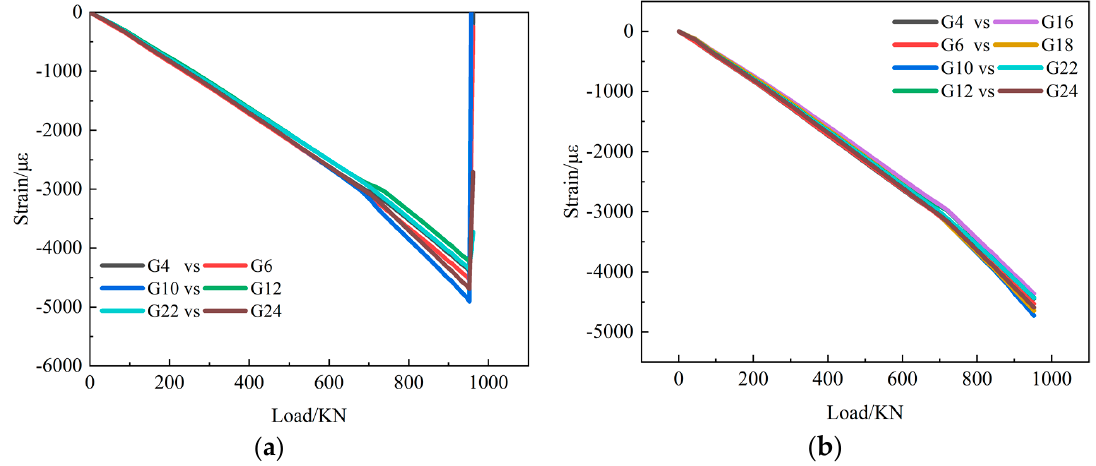
Figure 9. Back-to-back strain measuring points on stiffener web. ( a ) C1-Satic-1; ( b ) C1-Fatigue-1.